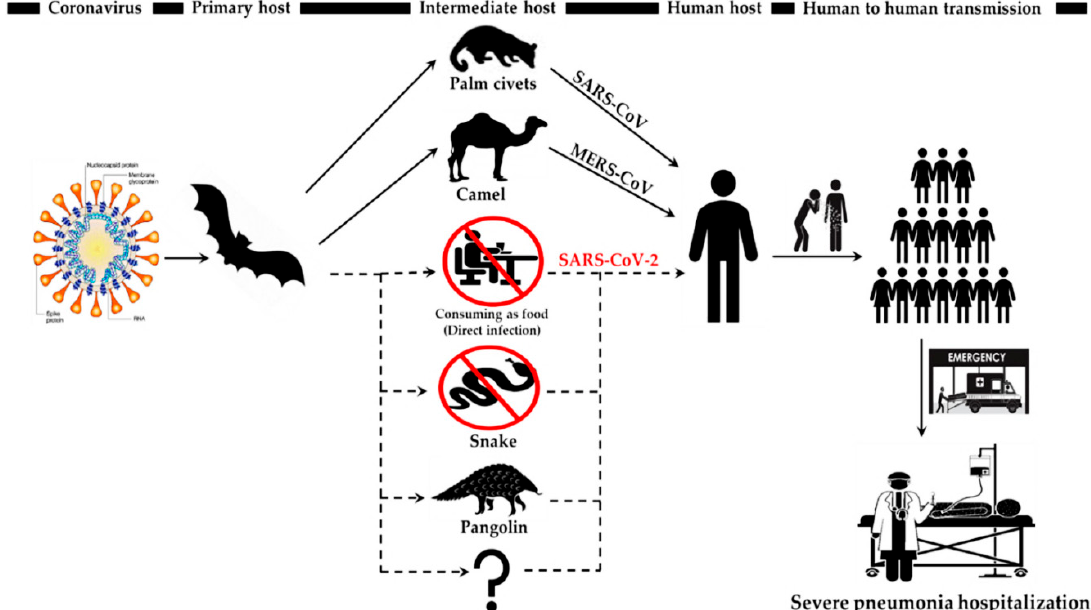
Figure 1. Important reservoir and possible interspecies transmission methods of SARS- and MERS-CoVs and SARS-CoV-2. Reproduced with permission from Ref. [8].